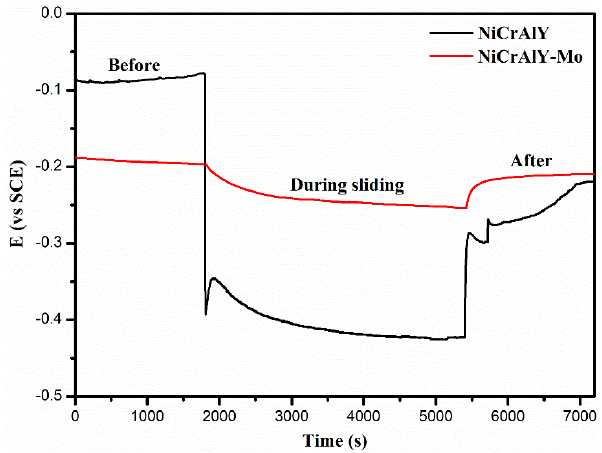
Figure 4. Evolution of OCP before, during and after tribocorrosion in artificial seawater.